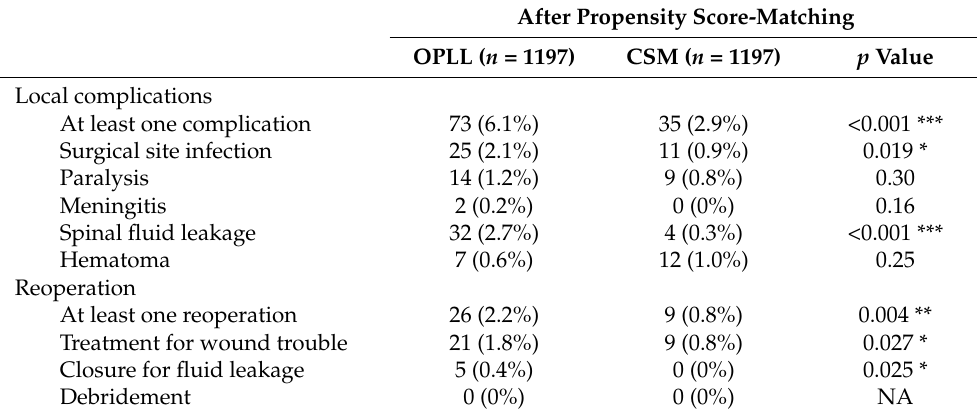
Table 3. Local complications and reoperation after matching.